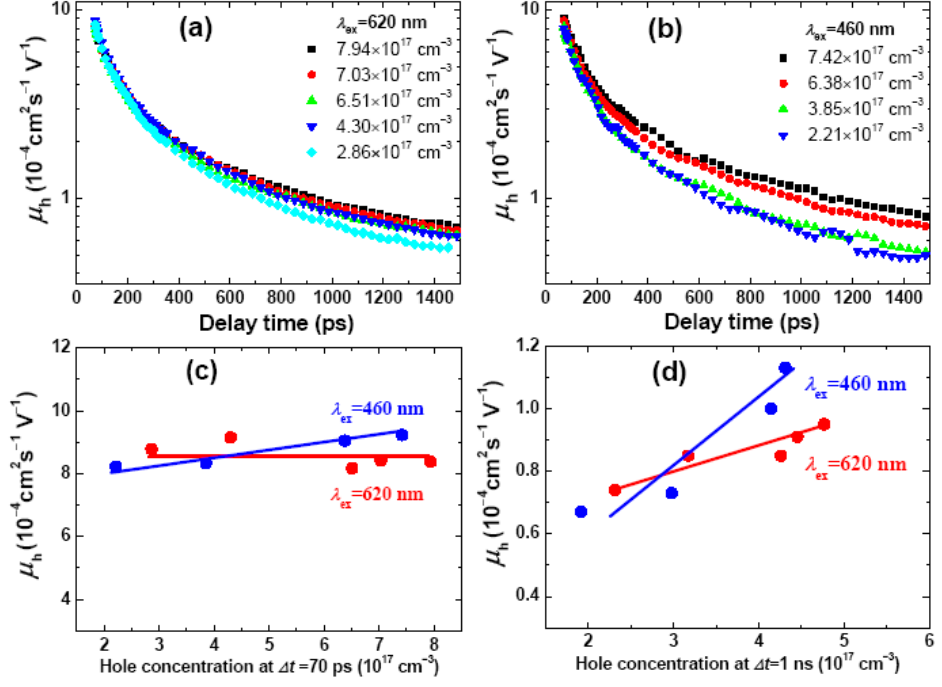
Figure 4. Temporal evolution profiles of hole mobility (  P3HT/PC BM films (1:1, w/w) under photoexcitation at ( a ) 620 nm and ( b ) 460 nm. Hole 61 concentration at  t = 70 ps are indicated in each panel. Change of  ( d )  t = 1 ns as a function of hole concentration. The excitation wavelengths (  indicated in each panel. Solid lines are for guiding the eyes.